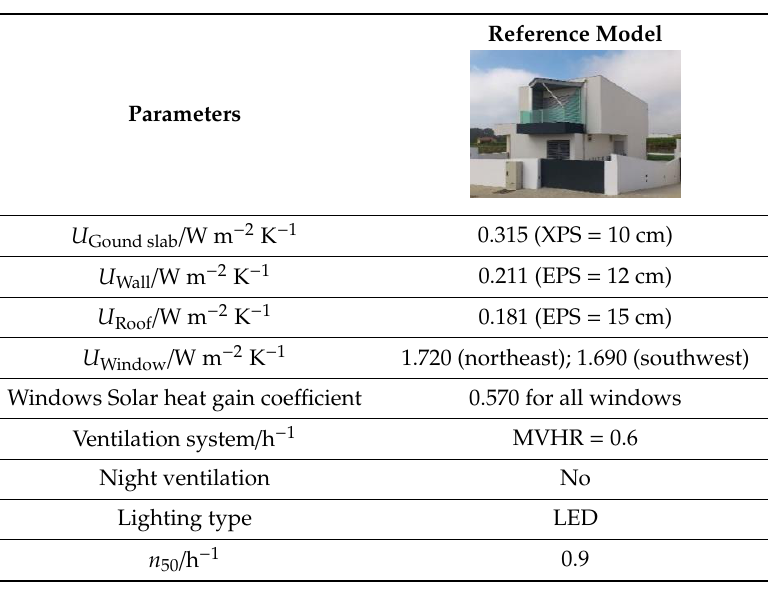
Table 1. Case study: general characterization.